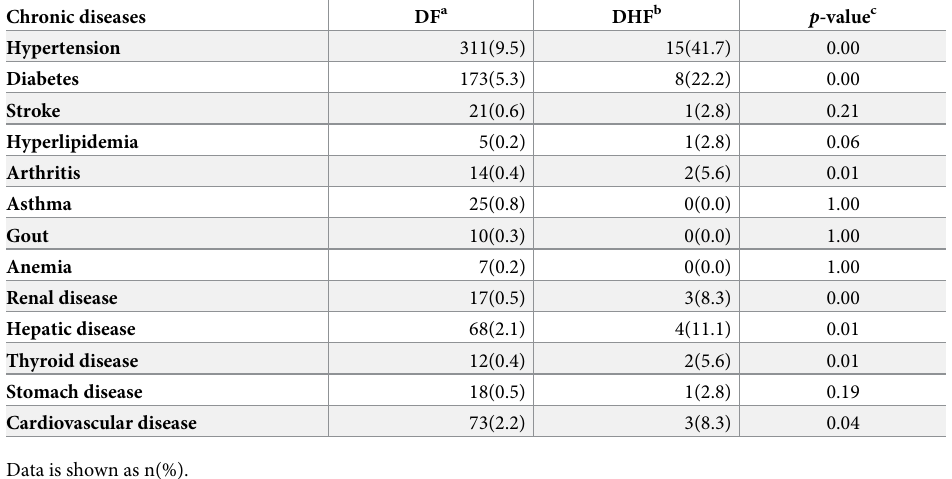
Table 5. Comparison of chronic diseases in patients with dengue fever and dengue hemorrhagic